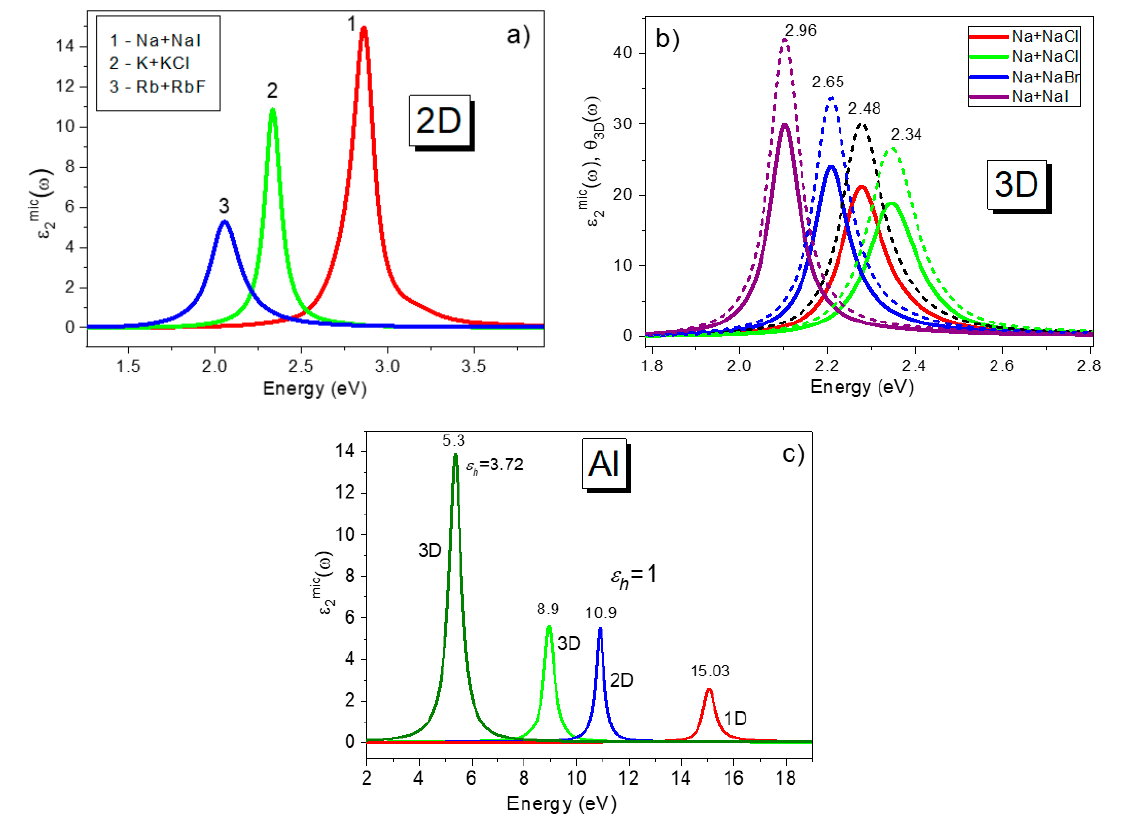
Figure 3. Calculated spectra ε mic 2 (𝜔) for ( a ) 2D confinement, shown for solid colloids Na + NaI, K + KF and Rb + RbF, ( b ) for 3D confinement, shown by solid lines for solid colloids Na + NaCl, Na + NaBr and Na + NaI corresponding to different ε h values. The dotted lines correspond to θ 3D ( ω ) calculated using Equation (9). ( c ) shows the results of calculations of ε mic 2 (𝜔) for 1D, 2D and 3D confinements for Al metal particles in air, at ε h = 1 (red, blue and green lines) and for 3D confinement for Al particles in an Al 2 O 3 solid matrix at ε h = 3.72 (olive line).